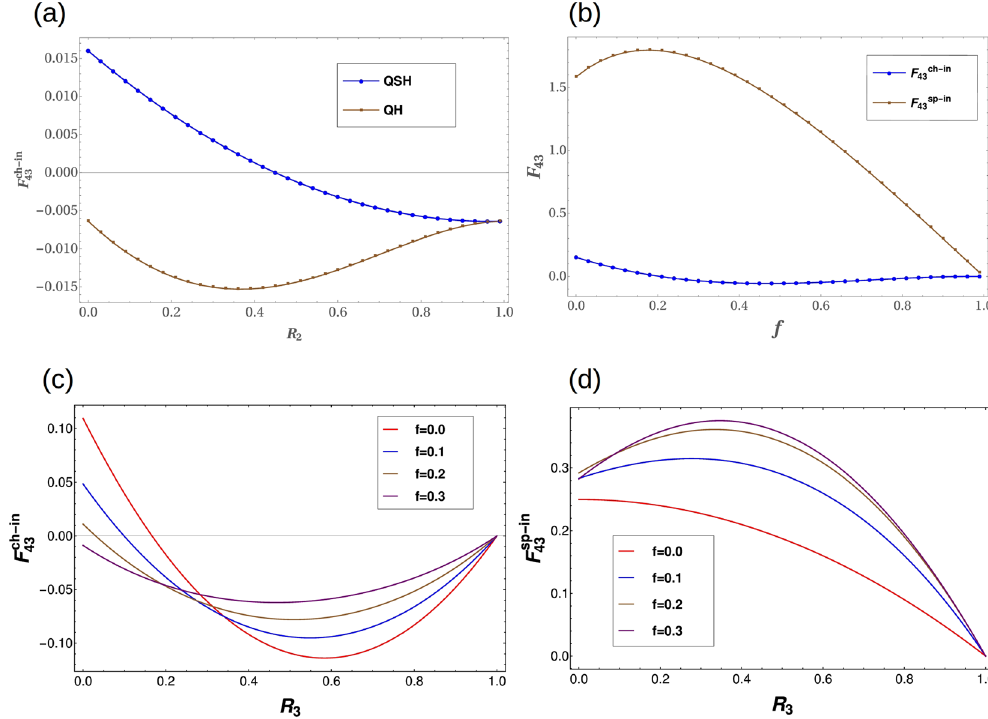
Figure 8. The effect of disorder on charge Fano factors ( a ) Topological QH versus Topological QSH cases, and the effect of intra-edge scattering on Fano factors in ( b ) for charge and spin Fano factors in trivial QSH phase. The charge Fano factor ( c ) and spin Fano factor ( d ) in the trivial phase (..) are completely distinct from topological ( = f 0 ) QSH phase. ( a ) Non-local charge Fano factors in topological helical QSH and topological chiral QH cases F ch vs R for all disordered probes ( = = . = . R R R 0, 0 2, 0 8 ) with inelastic scattering. Intra- 2 4 3 1 43 edge scattering probability: = f 0 . Note the sub-poissonian behavior in both cases for the charge Fano factor. ( b ) Non-local charge Fano factor F ch and spin Fano factor in trivial quasi-helical QSH sample F sp vs f (intra- 43 43 edge scattering probability) for two disordered probes ( = . = . R R 0 2, 0 8 ) with inelastic scattering. Note the 3 1 super Poissonian behavior of the spin Fano factor as compared to the charge Fano factor. ( c ) Non-local charge Fano factors for topological ( = f 0 ) and trivial ( ≠ f 0 ) QSH edge modes. F ch vs R for two disordered probes 3 43 ( = . R 0 5 ) with inelastic scattering as function of R . ( d ) Non-local spin Fano factors for topological ( = f 0 ) and 1 3 trivial ( ≠ f 0 ) QSH edge modes. F sp vs R for two disordered probes ( = . R 0 5 ) with inelastic scattering as 3 1 43 function of R . 3